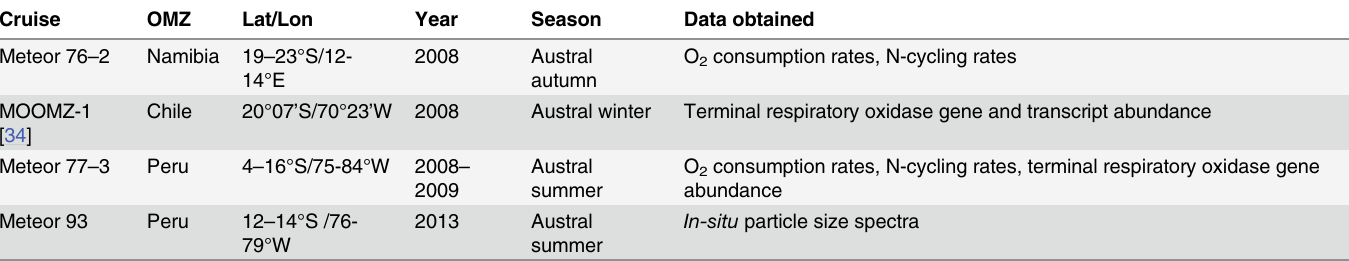
Table 1. Overview of sampling locations and times for the various types of data considered in this